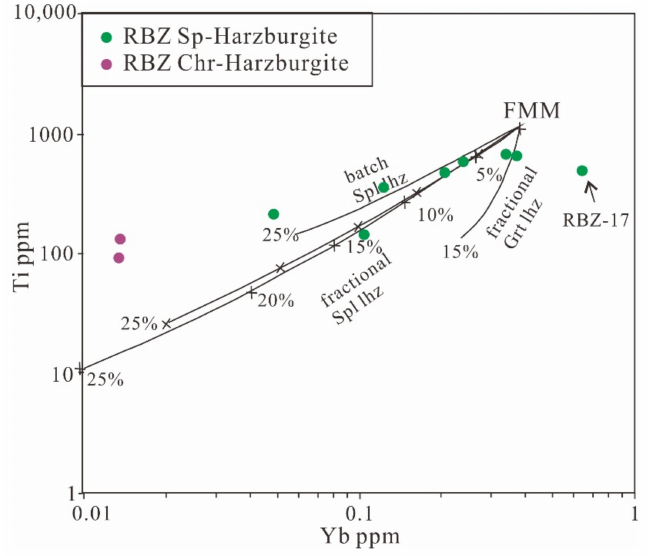
Figure 8. Diagram of whole-rock Ti-Yb covariation of harzburgites in Raobazhai. The partial melting trend follows that of